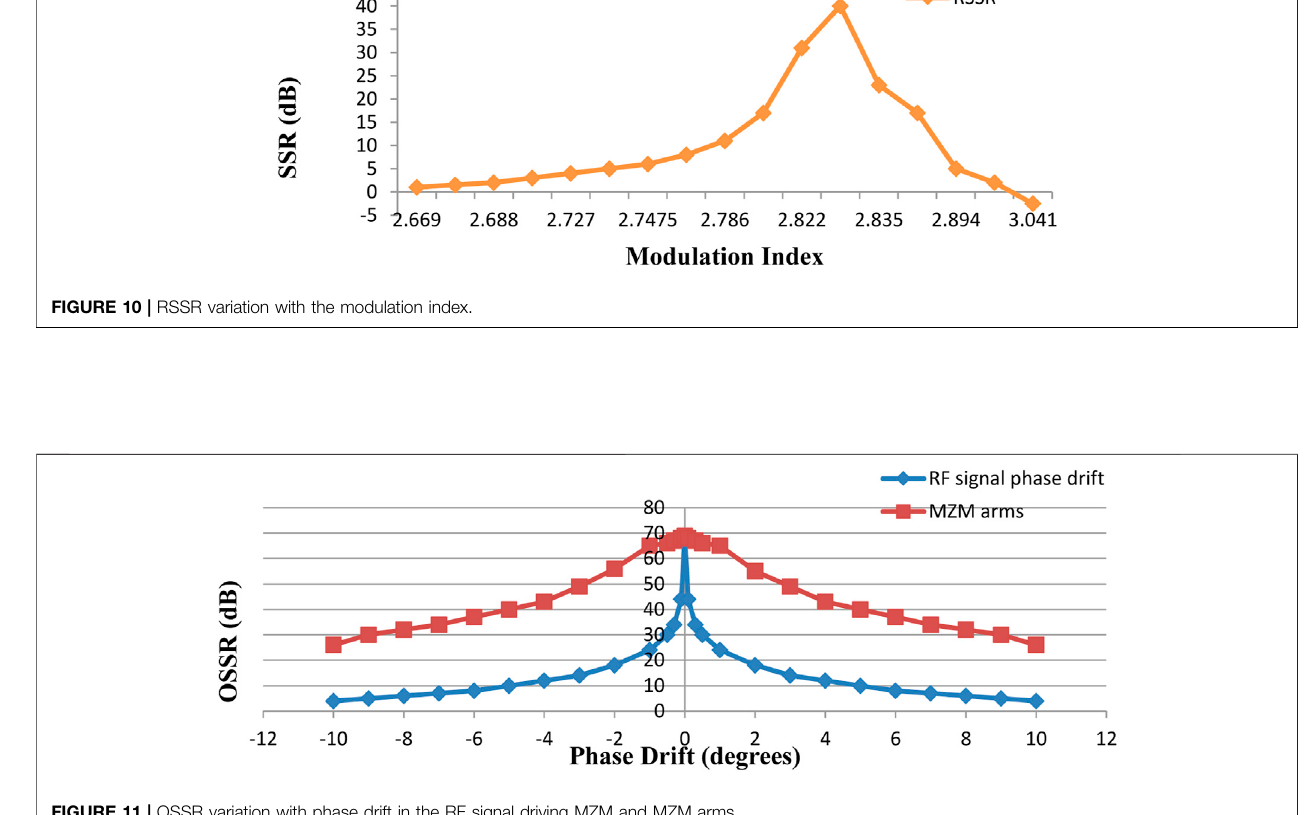
FIGURE 11 | OSSR variation with phase drift in the RF signal driving MZM and MZM arms.